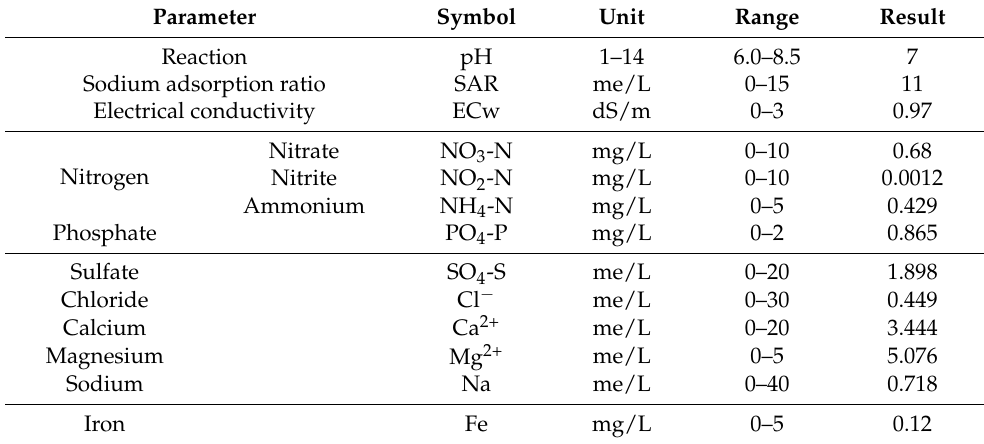
Table 2. Irrigation water